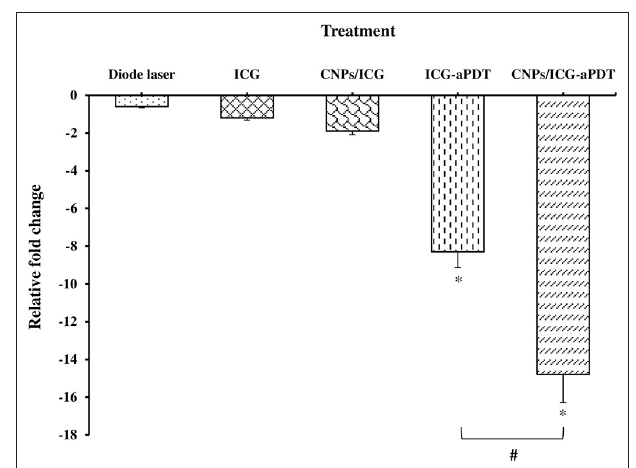
FIGURE 11 | Effects of test groups on the virulence genes expression of Aggregatibacter actinomycetemcomitans . *Significant difference from control ( P < 0.05). # Significant difference between ICG-aPDT and